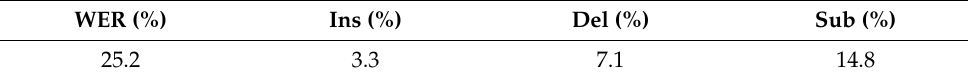
Table 7. Text processing results based on Word Error Rate